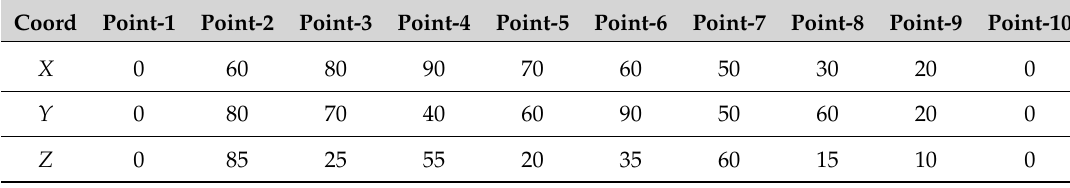
Table 3. 3D coordinate of turn points in Figure